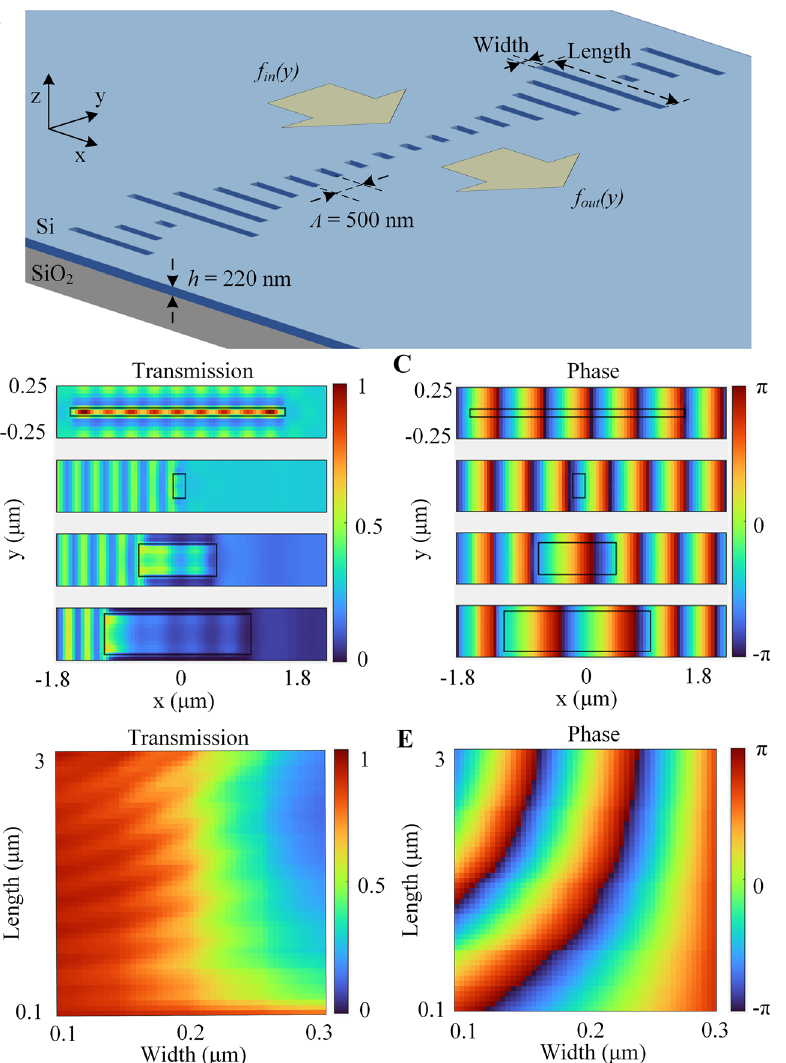
Figure 2: Framework and properties of the metasurface. (A) Perspective view of the designed framework. (B and C) Unit simulation under different slot width/length combinations. (D and E) The attained modulation